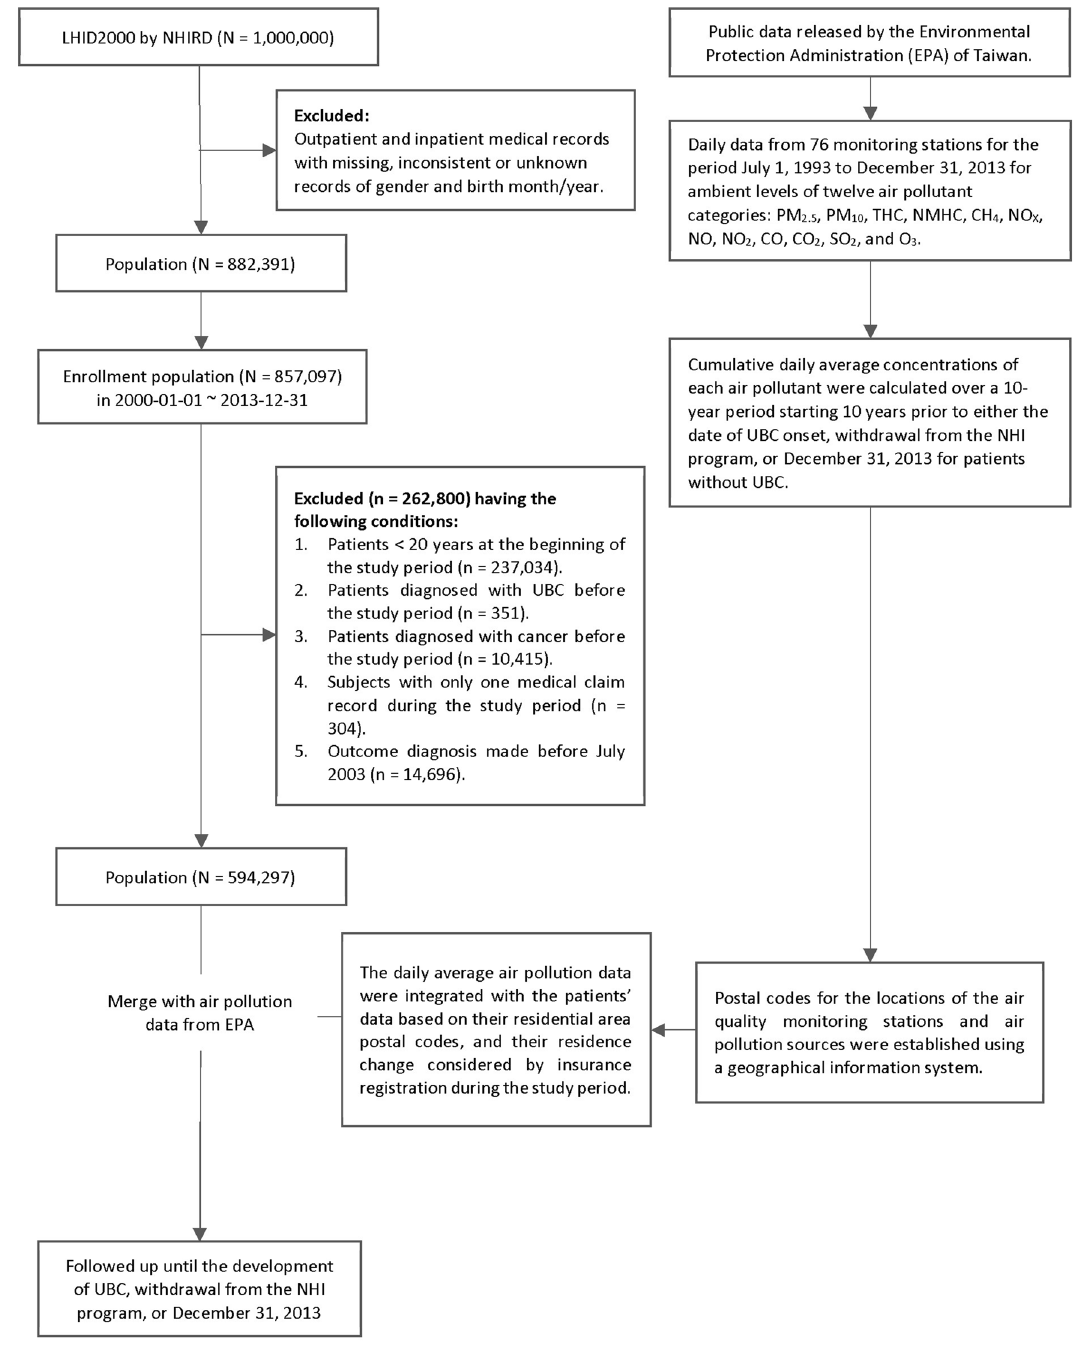
Figure 1. The study flow